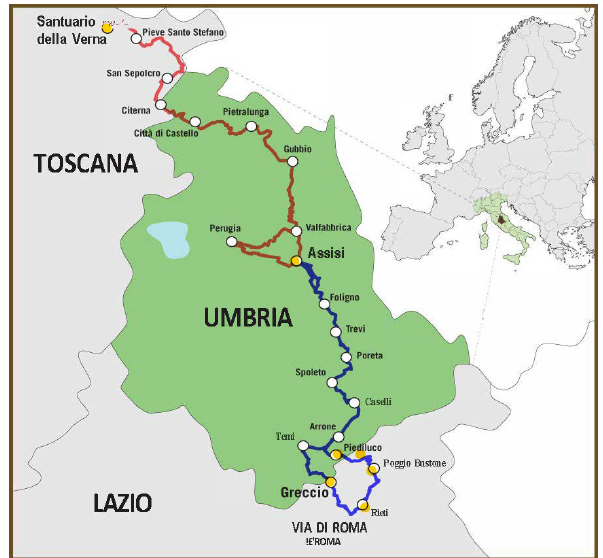
Figure 1. Map showing selected Franciscan monasteries in Tus- cany, Lazio and Umbria (in yellow) and walking paths from one to another. Note that there are others in Italy which were not chosen as part of this study. Source: public domain – Wiki